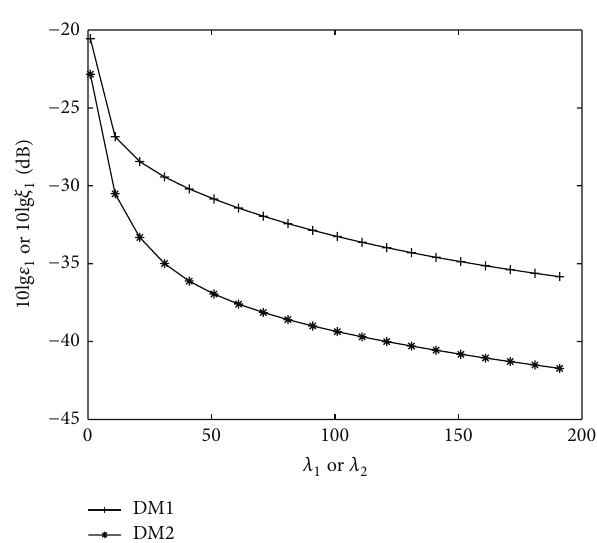
Figure 4: The relationship between the optimal Lagrange multiplier 𝜆 𝜆 1 ( 2 ) and the stopband attenuation which the filters were designed by DM1